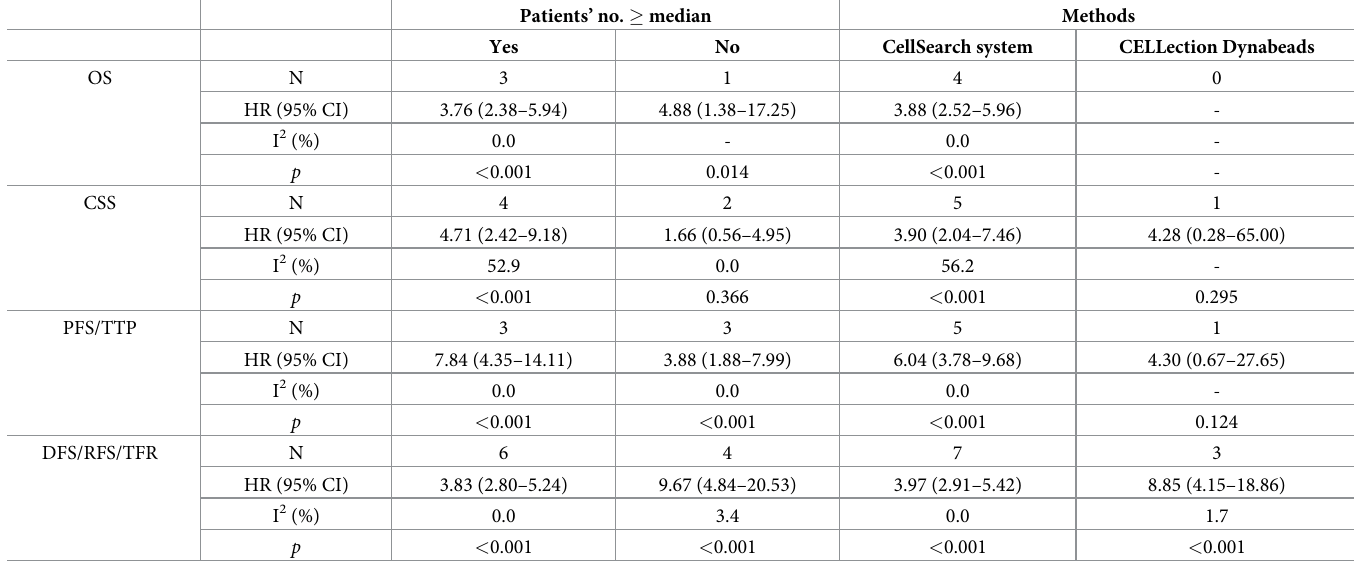
Table 3. Subgroup analyses of HRs based on different numbers of patients and detection